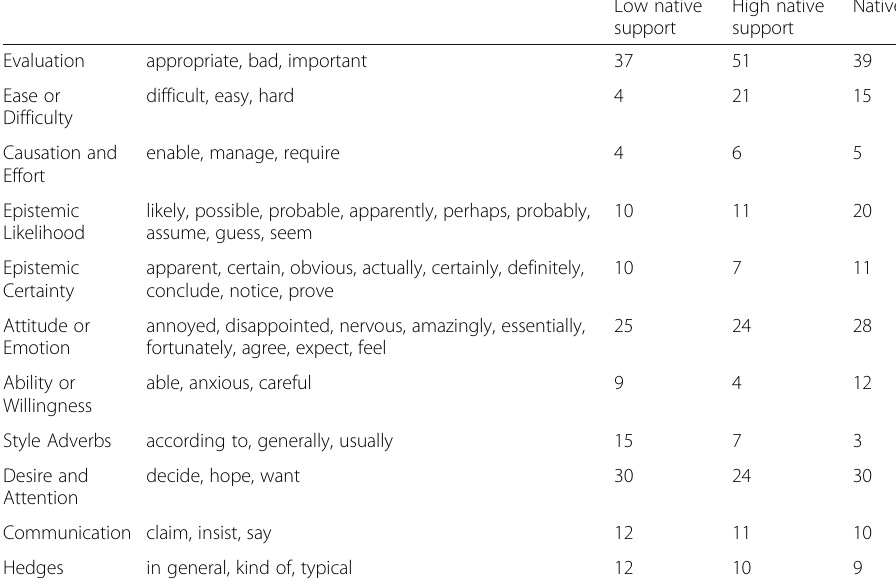
Table 4 Indicators of style: use of stances and